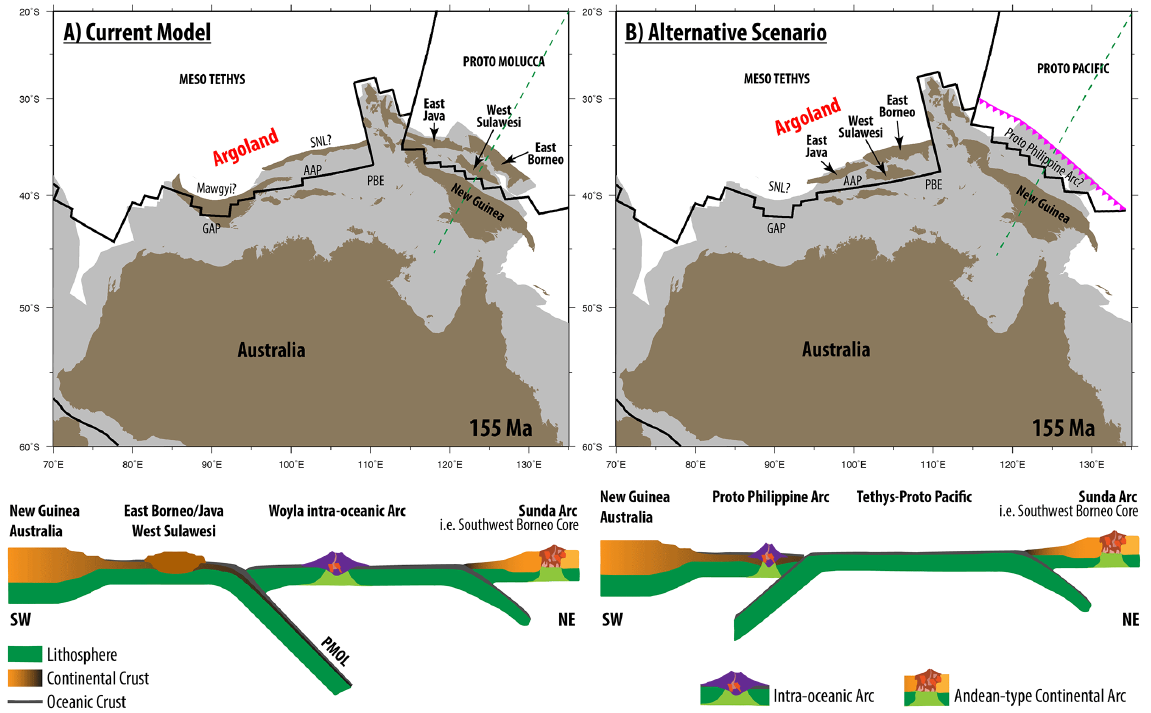
Fig. 11. End-member pre-rift scenarios along northern Gondwana during the latest Jurassic ( ∼ 155Ma) rift timing with a triple junction detaching the East Java, West Sulawesi, East Borneo and Mangkalihat from New Guinea driven by north-dipping subduction along the Woyla intra-oceanic arc representing the model implemented in this study (left). Alternatively, these blocks may have originated in the Argo Abyssal Plain (AAP), and a back-arc scenario may have existed along New Guinea (right), similar to the Incertus Arc proposed by Hall (2012). However, if this back-arc spreading did not detach continental blocks, then it may be the source for the proto-Philippine Arc. It is beyond the scope of this study to resolve whether the Mawgyi Nappes on West Burma or the Woyla Terranes on Sumatra contain microcontinental blocks, as it remains a continued source of controversy. We prefer the accretion of buoyant microcontinents in this region in order to account for the closure mechanism of the Woyla back arc in the Late Cretaceous. GAP–Gascoyne Abyssal Plain, PBE–proto-Banda Embayment, SNL–Sikuleh, Natal, Lolotoi and Bengkulu microcontinents. Schematic cross sections approximately follow dashed green line and are modified from Bouilhol et al. (2013). Not to